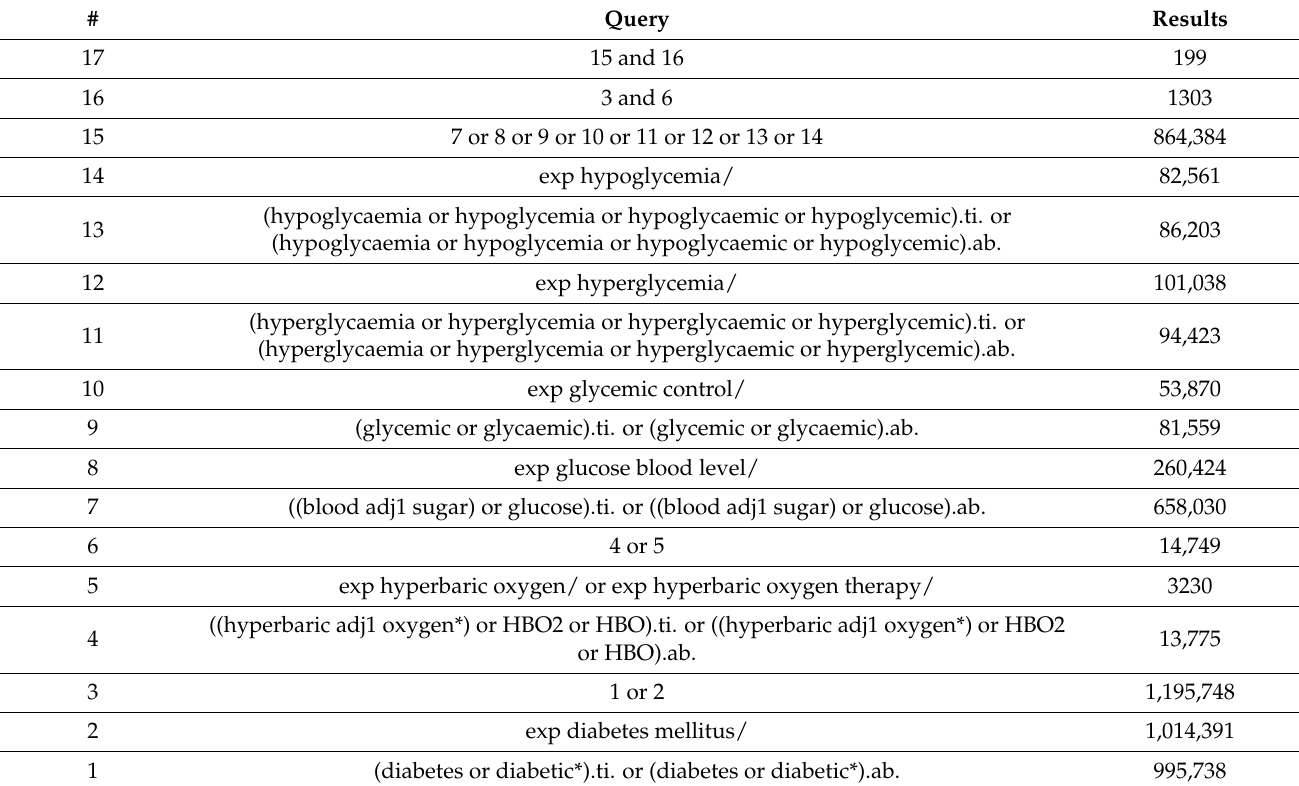
Table A3. Demonstrating the search strategy used on the Embase